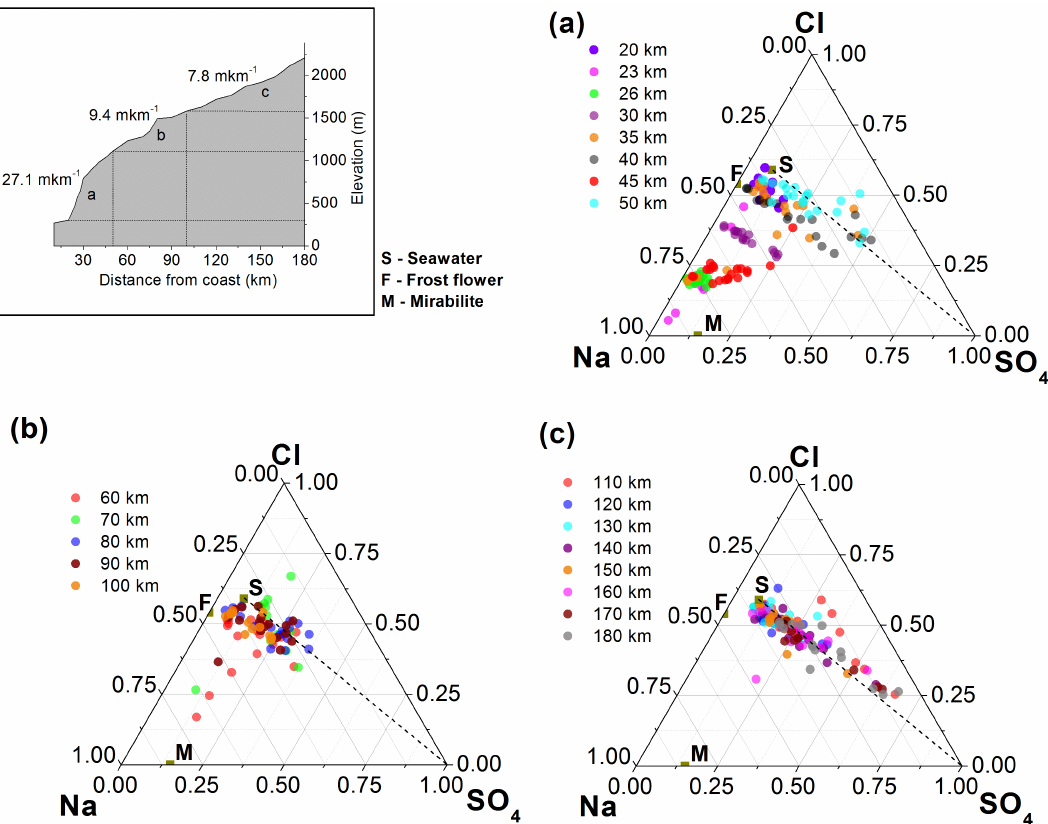
Fig. 5. Plot showing sea-salt modifications with respect to reference seawater (S) in snow samples from coastal (a) , midway (b) and the interior (c) of the transect. Inset on the top left shows changes in the elevation and slope along the transect. See text for